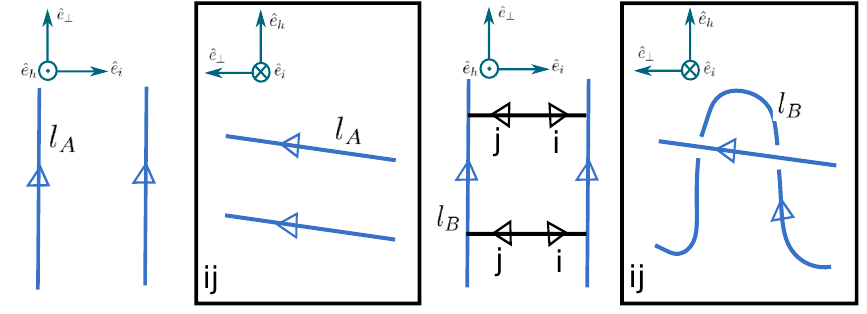
Figure 52 . The second Reidemeister